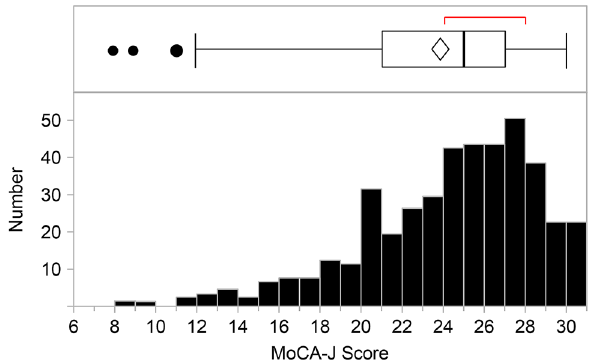
Figure 1. Montreal Cognitive Assessment-Japan (MoCA-J) score of patients on hemodialysis. The histogram illustrates the MoCA-J scores of the studied patients; of the 421 included patients, 58.2% (245 patients) had a MoCA-J score < 26.